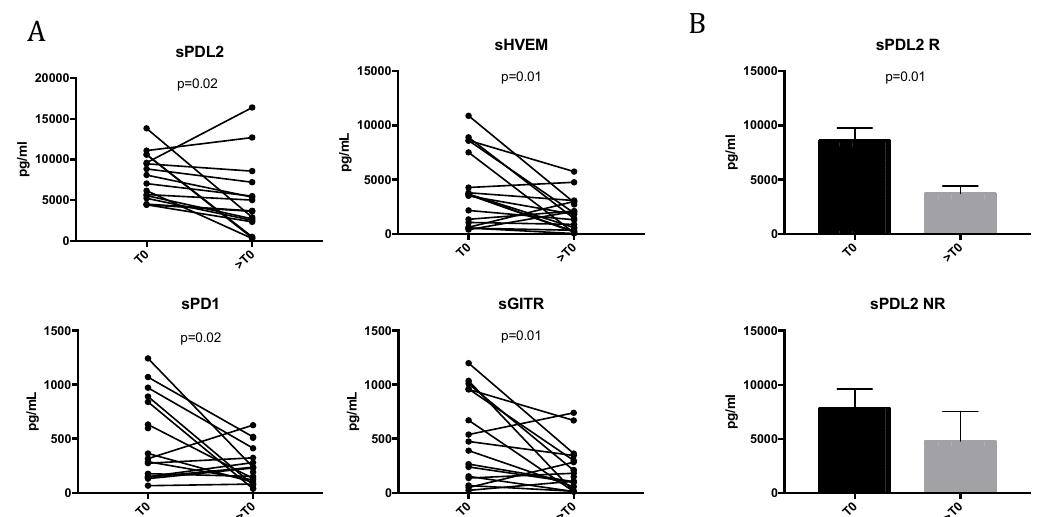
Figure 2. Changes in the soluble immune checkpoint-related proteins during TKI therapy in mRCC patients. ( A ) Analysis of soluble immune checkpoint-related proteins levels (i.e., sPDL2, sHVEM, sPD1, and sGITR) in patients with mRCC at baseline (T0) and after 3–4 months of TKI treatment (>T0). The proteins were analyzed by Luminex multiplex assay and the results are reported as the concentration (pg / mL) of soluble checkpoint inhibitors present in the serum of mRCC patients. ( B ) sPDL2 levels in the serum of mRCC responsive (R) and non-responsive (NR) patients analyzed at T0 and > T0. sPDL2 resulted in the only significantly modulated molecule associated with response to TKI treatment. Statistical significance was determined by a Student’s paired t -test, and a p -value < 0.05 was considered statistically significant.